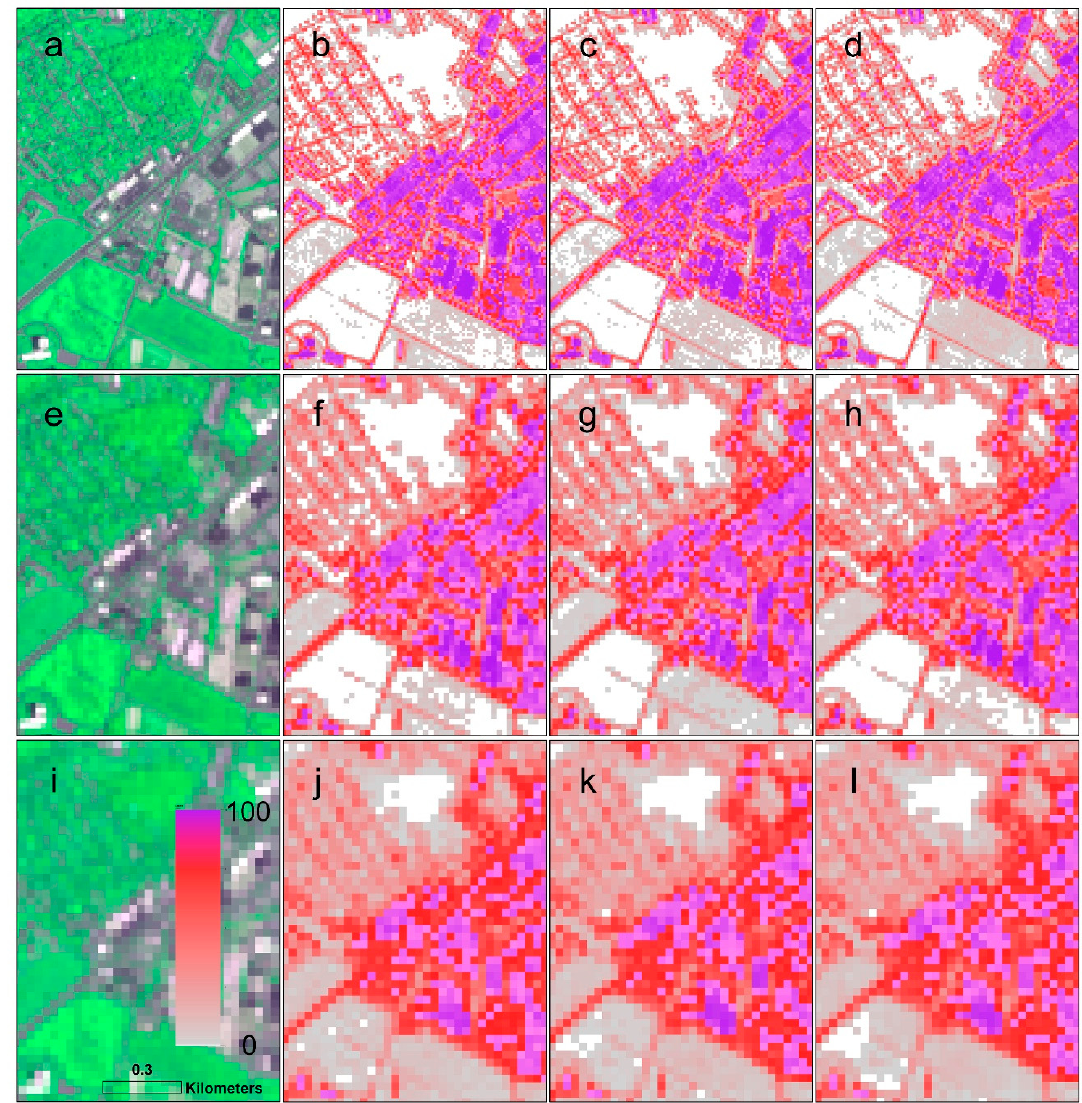
Figure 5. WV3 images at 10-m ( a ), 20-m ( e ), and 30-m ( i ) resolutions from the highlighted area in Figure 4a and derived ISAs from images with half, three-quarters, and twice the Landsat OLI SNRs at 10-m ( b – d ), 20-m ( f – h ), 30-m ( j – l ) resolutions. The non-ISAs are in white.